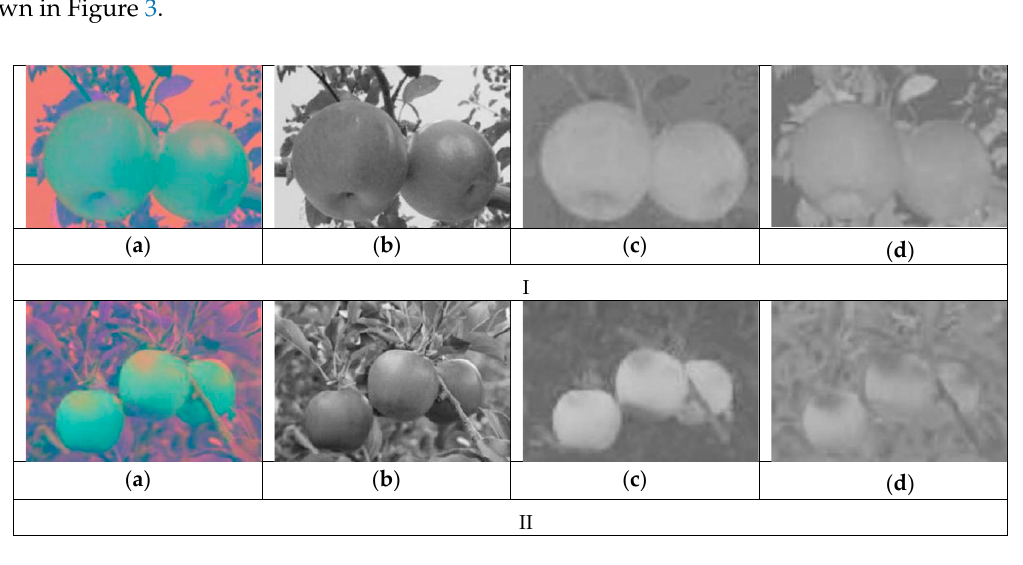
Figure 3. Overlapped images under the Lab color space. ( a ) Lab image; ( b ) L component; ( c ) a component; ( d ) b component.